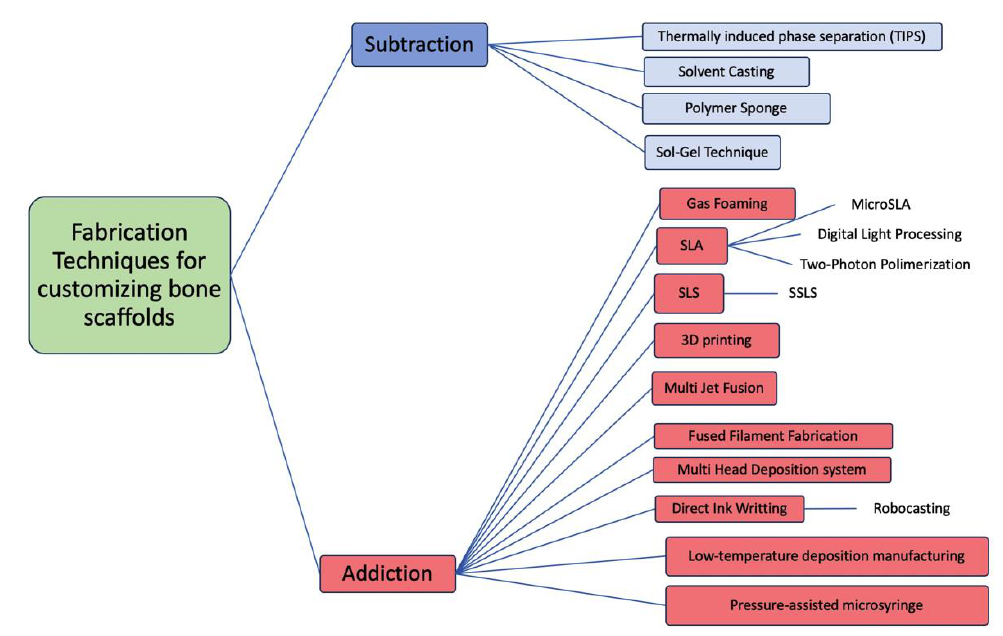
Figure 2. Diagram classifying the main scaffold fabrication techniques according to the manufacturing method.